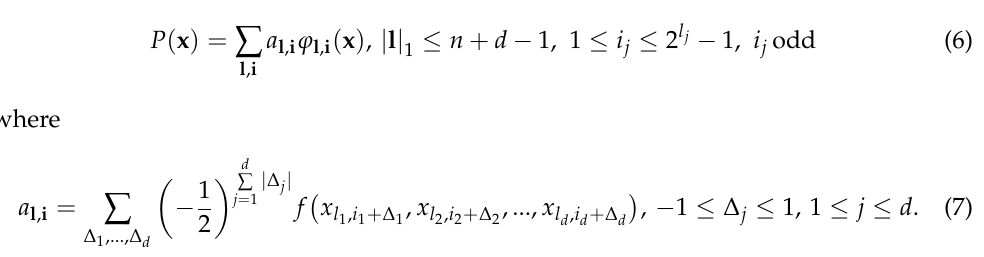
Figure 3. Sparse grid of the third level: black dots—sparse grid; black and grey dots—full grid: ( a ) sets of points corre- sponding to basis functions of the same level; ( b ) combining all points into one grid.